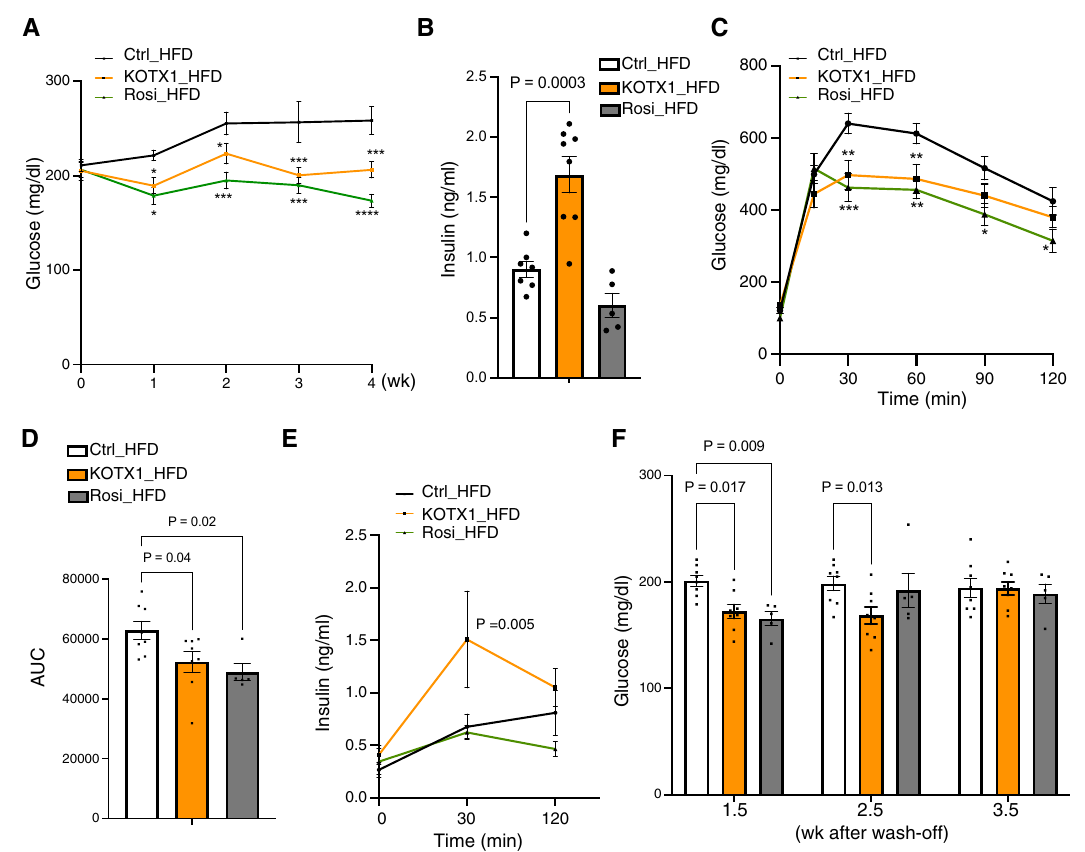
Fig. 4 | KOTX1 treatment in DIO model. A Non-fasting glucose in male DIO mice treatedwithKOTX1-,Rosi-orcontrolfor4weeks.Dataareexpressedasmeans±SEM for n =8, 8, or 5 for vehicle-control, KOTX1 or Rosi-HFD. Two-way ANOVA with multiple comparison test was used for statistical analysis. The P value was 0.036, 0.036,0.0003,or0.0008,for1,2,3or4weeksincomparisonofKOTX1withvehicle. In comparison of Rosi with vehicle, the p value was 0.015, 0.0007, 0.0002, or 0.00001, for 1, 2, 3 or 4 weeks of treatment. * P <0.05, ** P <0.01, *** P <0.001, **** P <0.0001. B plasma insulin in male DIO mice treated with KOTX1-, Rosi- or controlfor 4 weeks. Data are expressed as means±SEM for n =7, 8, or 5 for vehicle- control, KOTX1 or Rosi-HFD. One-way ANOVA with multiple comparison test was used for statistical analysis. C IPGTT in male DIO mice treated with KOTX1-, Rosi- or controlfor4weeks. Dataare expressed asmeans±SEM for n =8, 8,or5for vehicle- control, KOTX1 or Rosi-HFD. Two-way ANOVA with multiple comparison test was